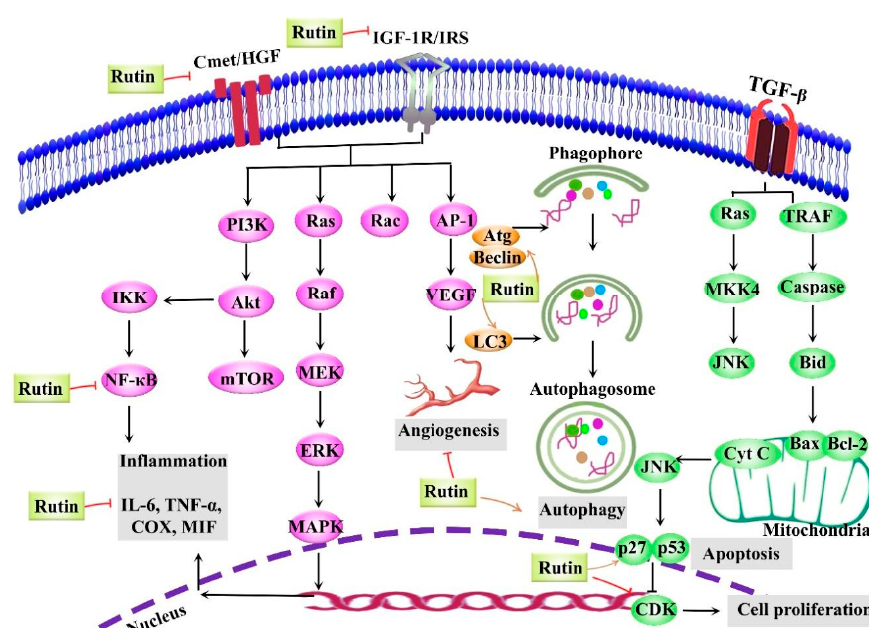
Figure 4. Numerous dysregulated mechanisms and therapeutic targets implicated in the anticancer effects of rutin. Akt, protein kinase B; Atg, autophagy-related gene; Bax, Bcl-2-associated X protein; Bcl-2, B-cell lymphoma 2; CDK, cyclin-dependent kinase; C-met/HGF, mesenchymal–epithelial transition factor/hepatocyte growth factor; COX, cyclooxygenase; Cyt C, cytochrome c; ERK, extracellular signal-regulated kinase; IGF-1R/IRS-1, insulin-like growth factor 1 receptor /insulin receptor substrate-1; IKK, I κ B kinase; IL-6, interleukin-6; JNK, Jun N-terminal Kinase; LC3, light chain 3; MAPK, mitogen-activated protein kinase; MEK, mitogen-activated protein kinase kinase; MIF, macrophage migration inhibitory factor; MKK, MAPK kinase; mTOR, mammalian target of rapamycin; NF- κ B, nuclear factor- κ B; PI3K, phosphatidylinositol 3-Kinase; TGF- β , transforming growth factor- β ; TNF- α , tumor necrosis factor- α ; TRAF, tumor necrosis factor receptor-associated factor; VEGF, vascular endothelial growth factor.